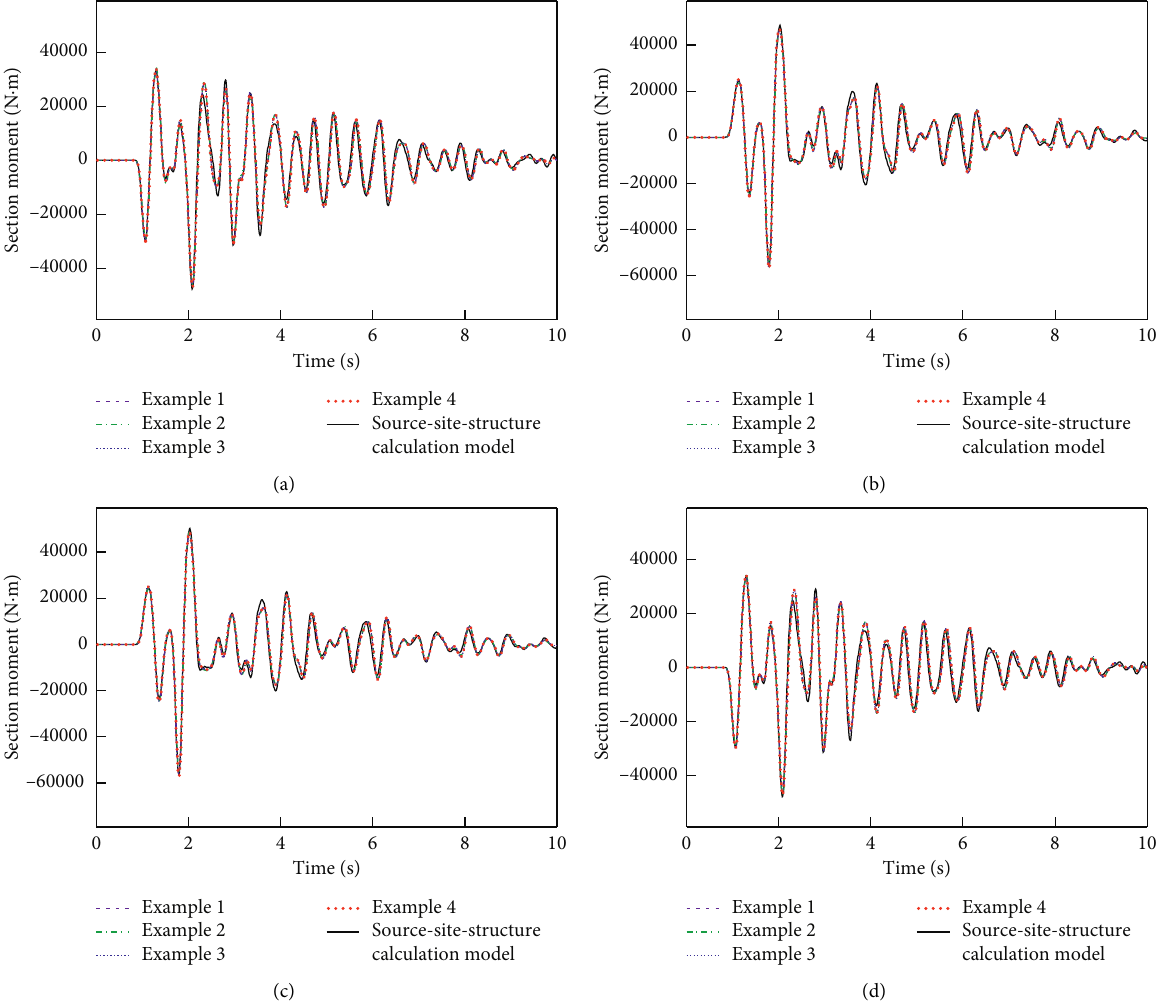
Figure 20: Section bending moment history of the four examples of a complex layered field: (a) section (A), (b) section (B), (c) section (C), and (d) section